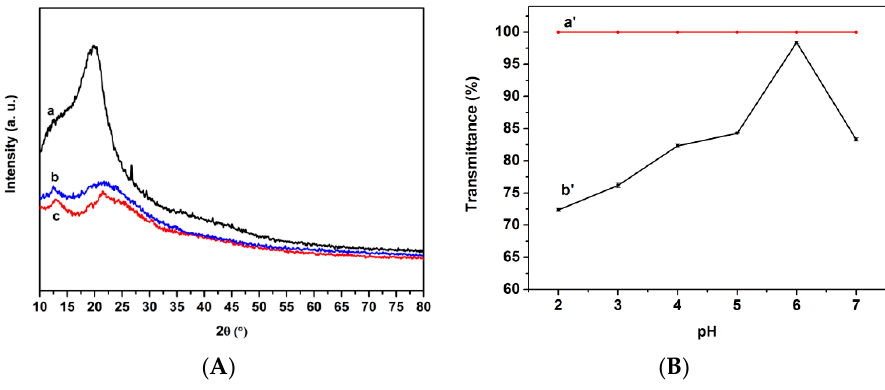
Figure 5. ( A) XRD patterns of a, chitosan, b, O -CMCS, c, chitosan-based biopolymer dye; ( B ) water solubility of a’, Acid Red GR dye; b’, chitosan-based biopolymer dye at different pH values.